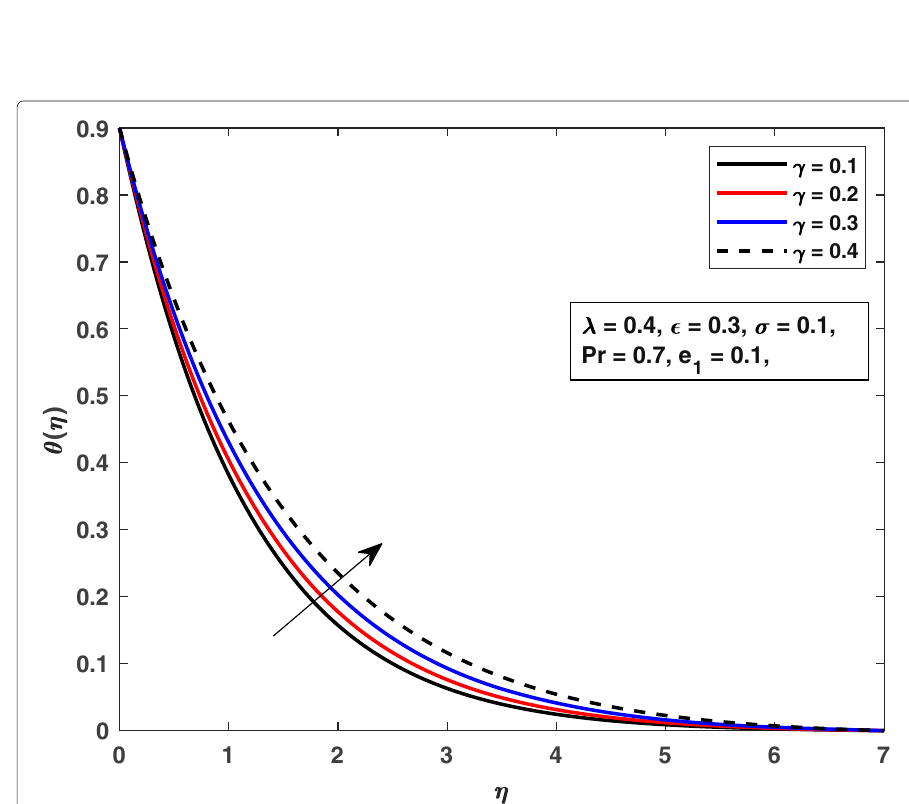
Fig. 13 Impact of the heat generation/absorption parameter γ on